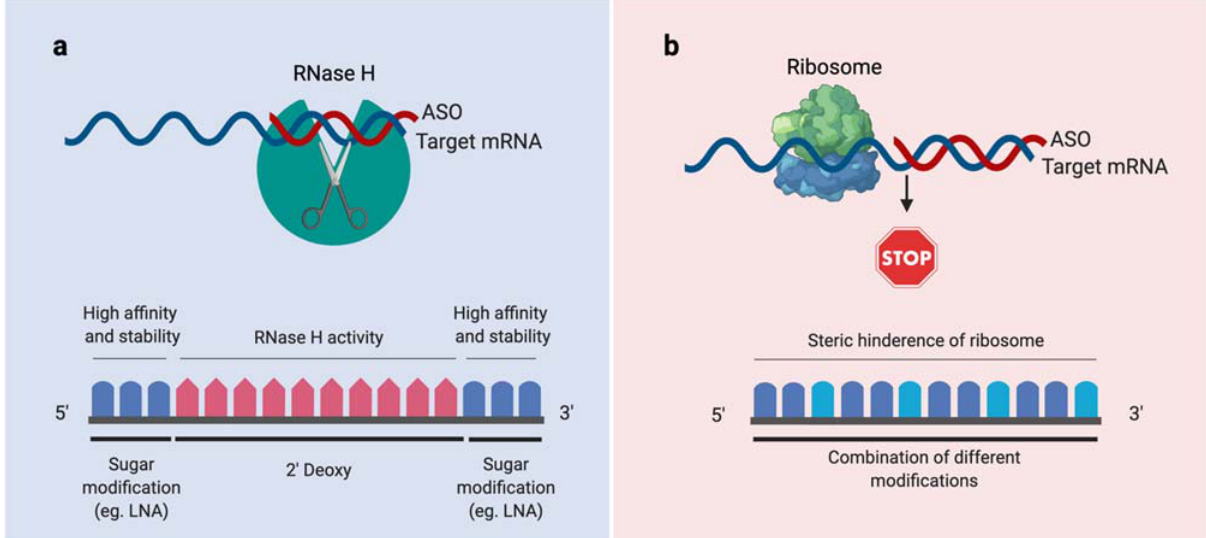
Figure 1. Different mechanisms that play a role in the modulation of the RNA function in bacteria. ( a ) Upon hybridization of a gapmer (red), the RNase H is recruited, and the target is degraded. ( b ) Steric hindrance of the ribosome caused by the hybridization between a steric blocker (red) and the complementary mRNA sequence. Figure created using BioRender.